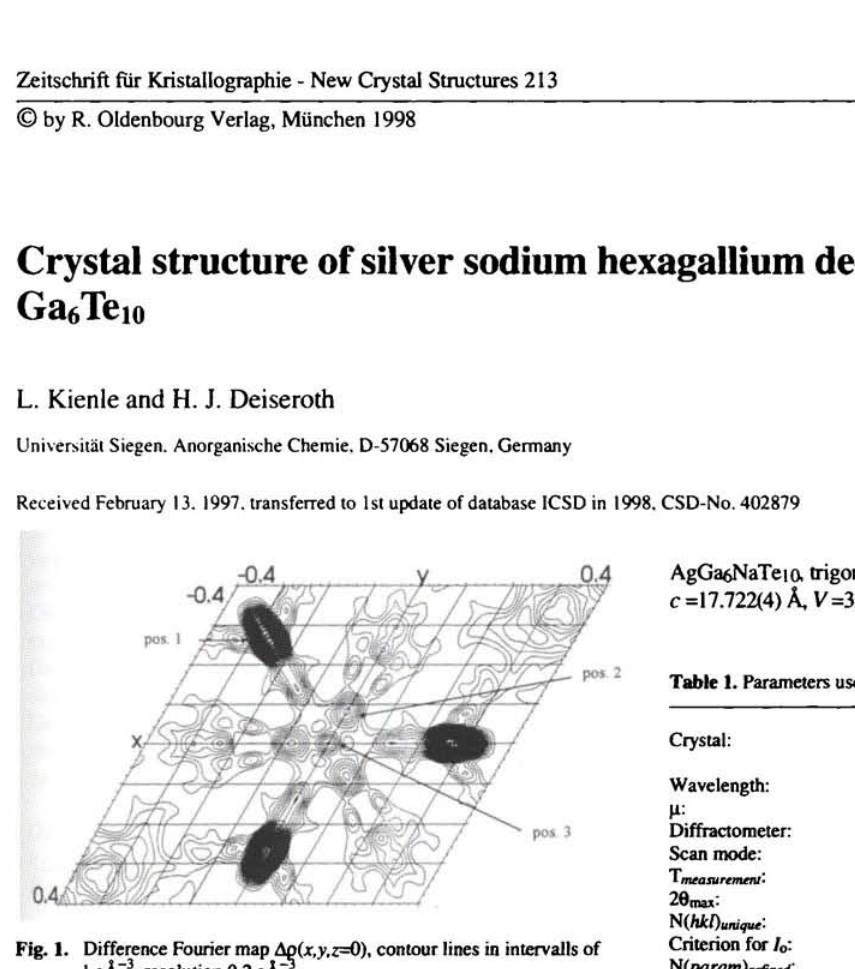
Fig. 1. Difference Fourier map До^у.г^гО), contour lines in intervalls of 1 еЛ"^, resolution 0.2 eA^.